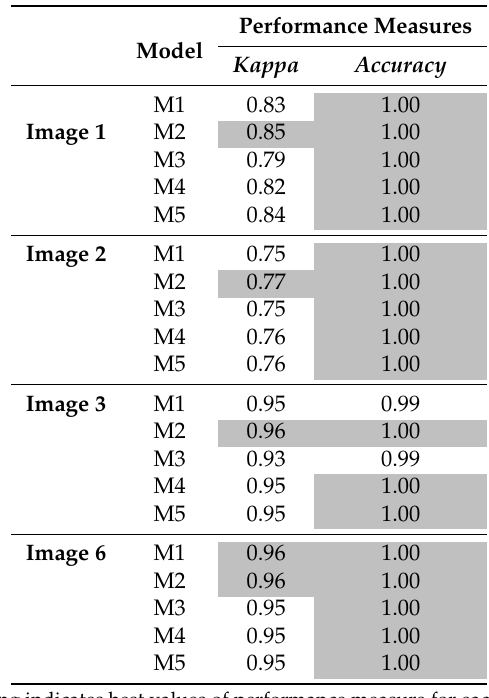
Table A3. Machine learning model results: metrics where both vineyard and background are weighted equally.